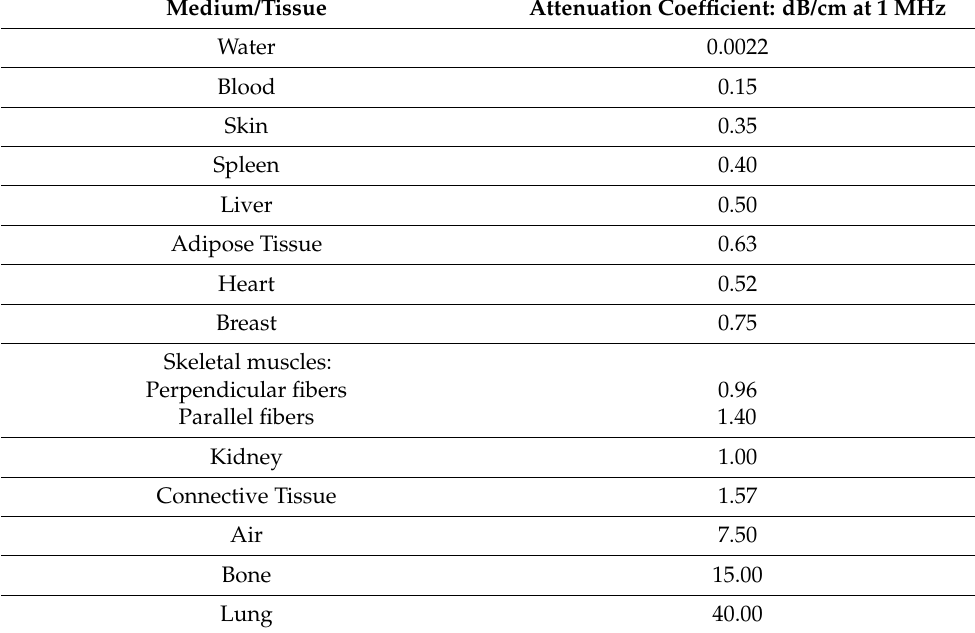
Table 4. Attenuation coefficients of various media or